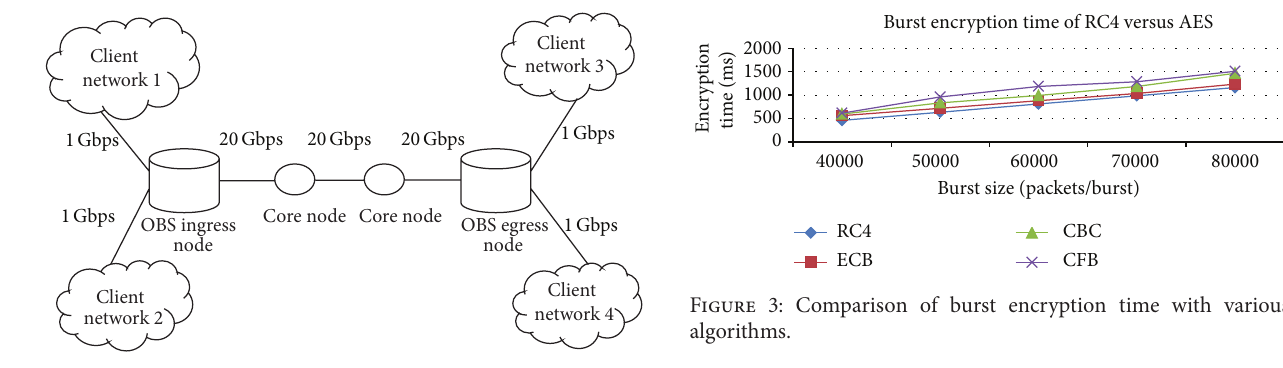
Figure 2: Simulation scenario. Table 6: Burst encryption time using RC4 and AES.